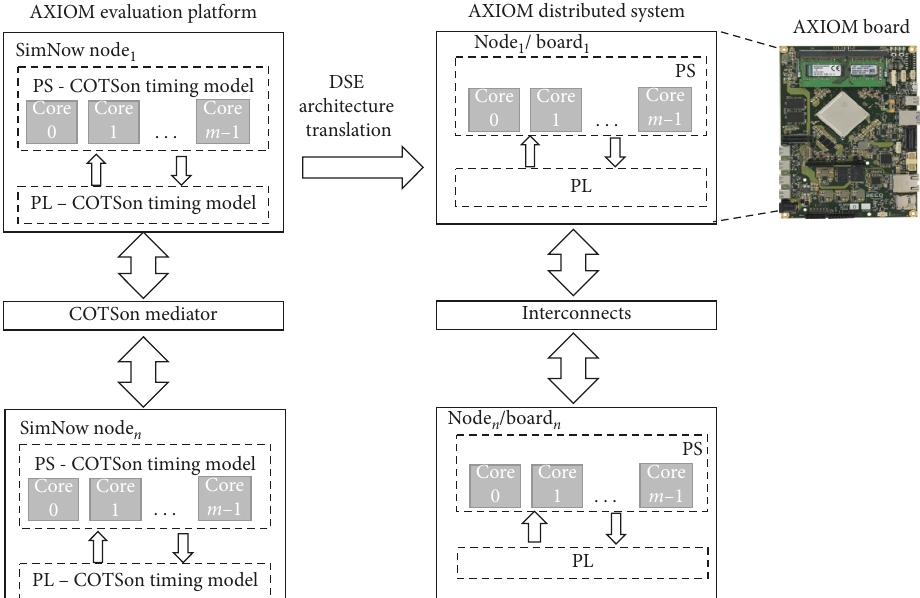
Figure 10: From COTSon Distributed System definition to AXIOM Distributed System by using the DSE tools. The processing system (PS), the programmable logic (PL), and the interconnects of the AXIOM board are simulated and evaluated into the COTSon framework with the definition of the respective timing